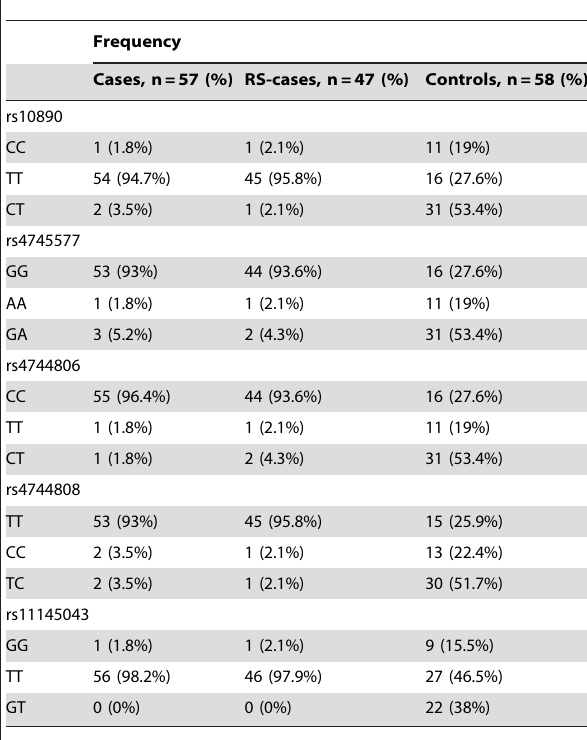
Table 1. Genetic association of ITR3 and SNPs of the FXN 3 9 - UTR with FRDA haplotype in cases versus controls.